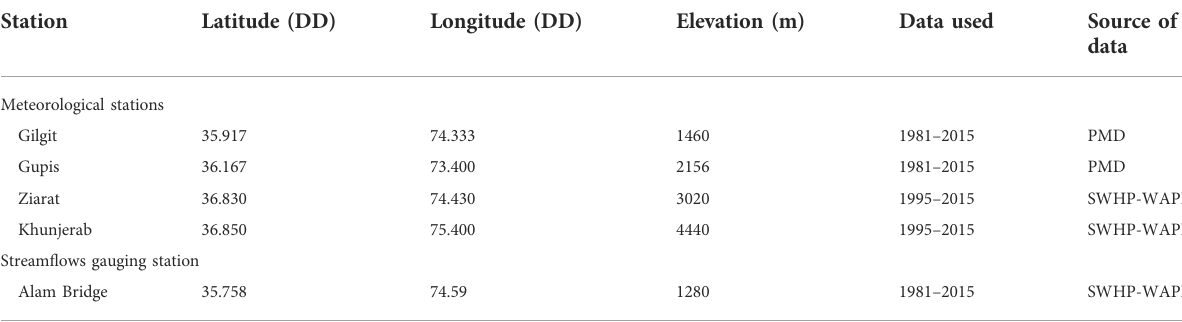
TABLE 2 List of hydro-meteorological stations used in the